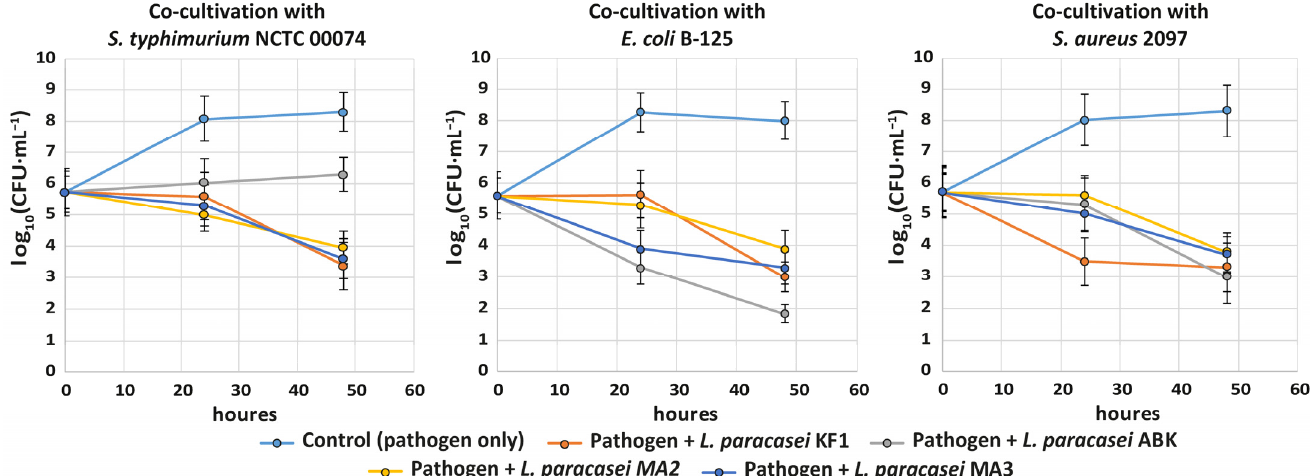
Figure 4. Changes in the viable cell count of S. typhimurium NCTC 00074, E. coli B-125 and S. aureus 2097 during single- and two-species cultivations with the kefir-derived (KF1 and ABK) and mahewu-derived (MA2 and MA3) strains of L. paracasei . The error bars represent the standard deviations from the mean.